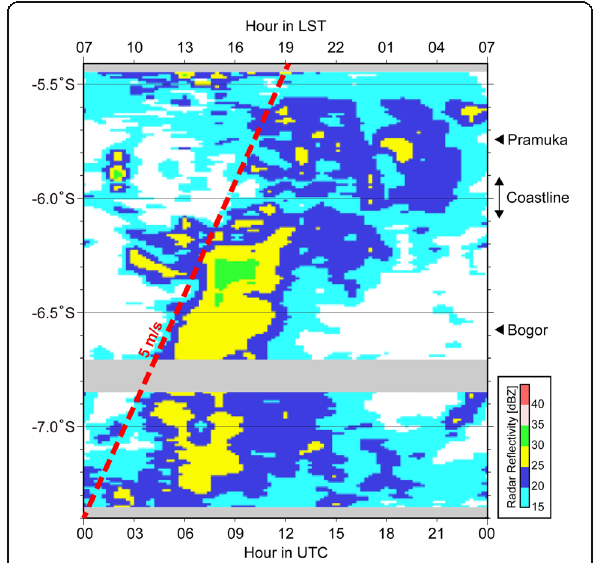
Fig. 6 Diurnal composite of the time – latitude cross section of the radar reflectivity at a 2 km height obtained by the Serpong C-band radar. The gray shading indicates areas with no available data. The latitudinal location of the northern and southern tips of the array (Pramuka and Bogor, respectively) and the approximate locations of the coastline are shown on the right axis to indicate the latitudinal range of the array. The red line indicates the propagation speed in 5 m/s northward, as a